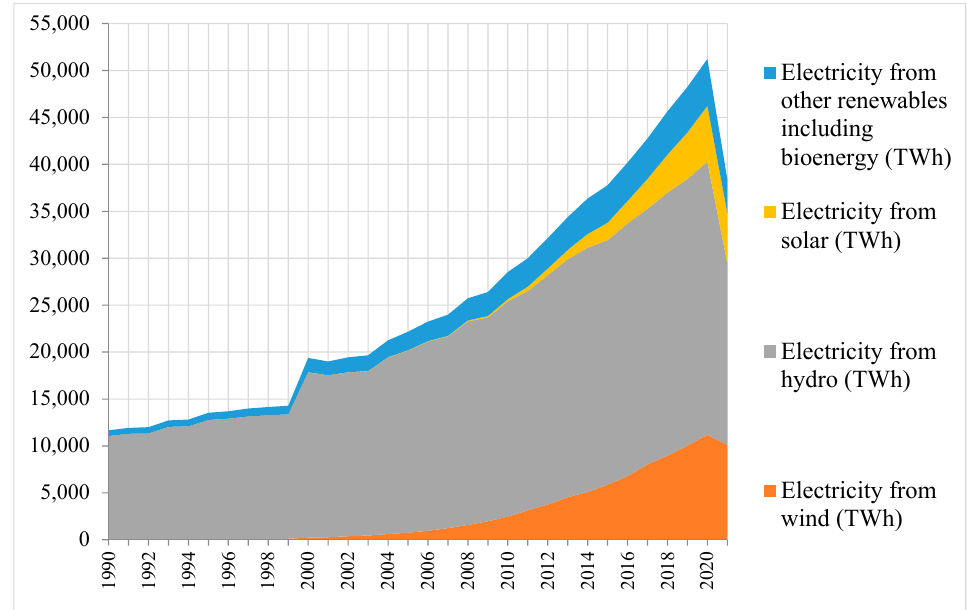
Figure 8. Transition of renewable energy generation around the world.